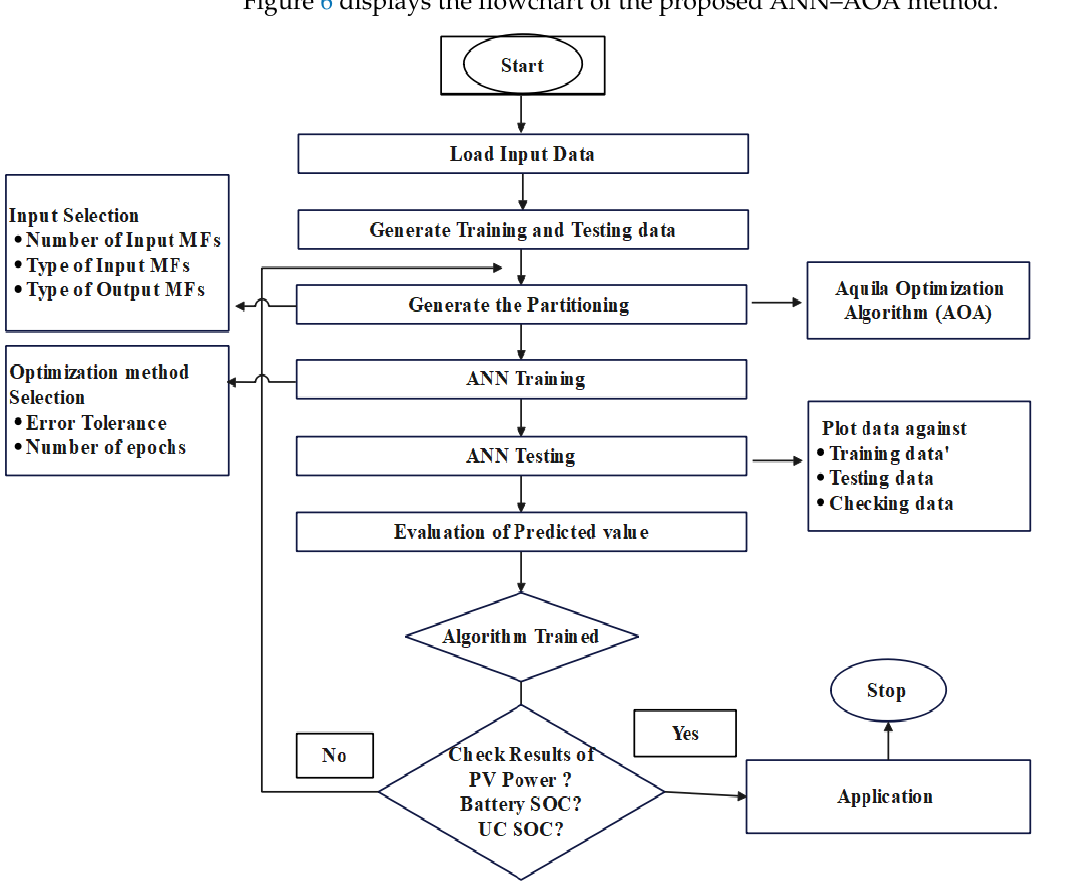
Figure 6. Flowchart of the proposed ANN–AOA